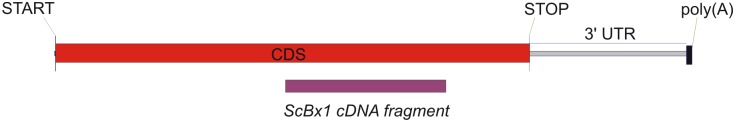
Schematic representation of cDNA (1290 bp) containing ScBx1 gene (JQ716987.1).Indicated are START and STOP codon, CDS, 3′-UTR region and the fragment cloned to the VIGS-BSMV vector for posttranscriptional gene silencing (ScBx1 cDNA fragment).